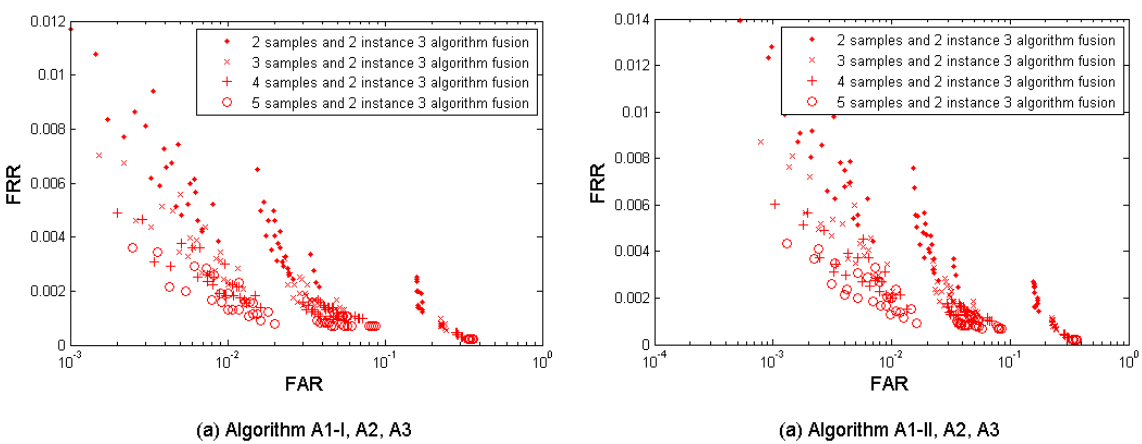
Figure 10. Multi-sample-instance-algorithm fusion results from the left and the right index fingers fusing the algorithms A1 (Set I), A1 (Set II), A2, and A3 developed in project